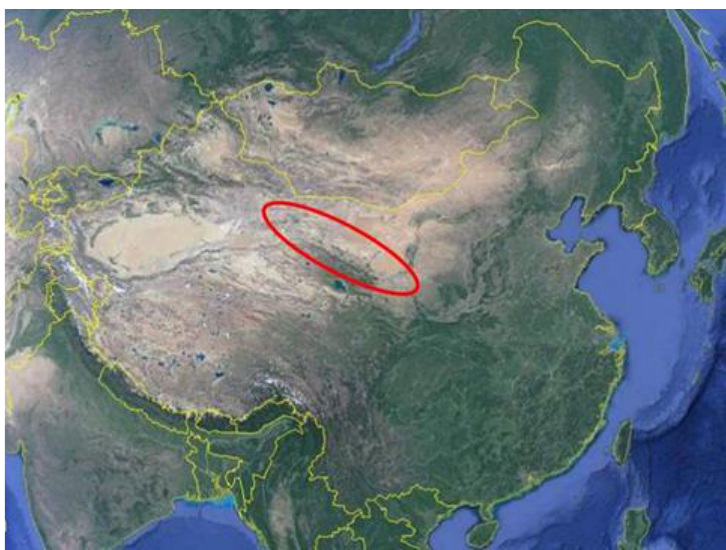
Figure 1. Gansu province in China (from Google Earth Pro V 7.3.4 (14 December 2015), 38°30′38.59″N, 99°34′03.75″E, Eye alt 7432.84 km, Landsat, Copernicus, SIO, NOAA, US Navy, NGA, GEBCO 2022, [46], modified).